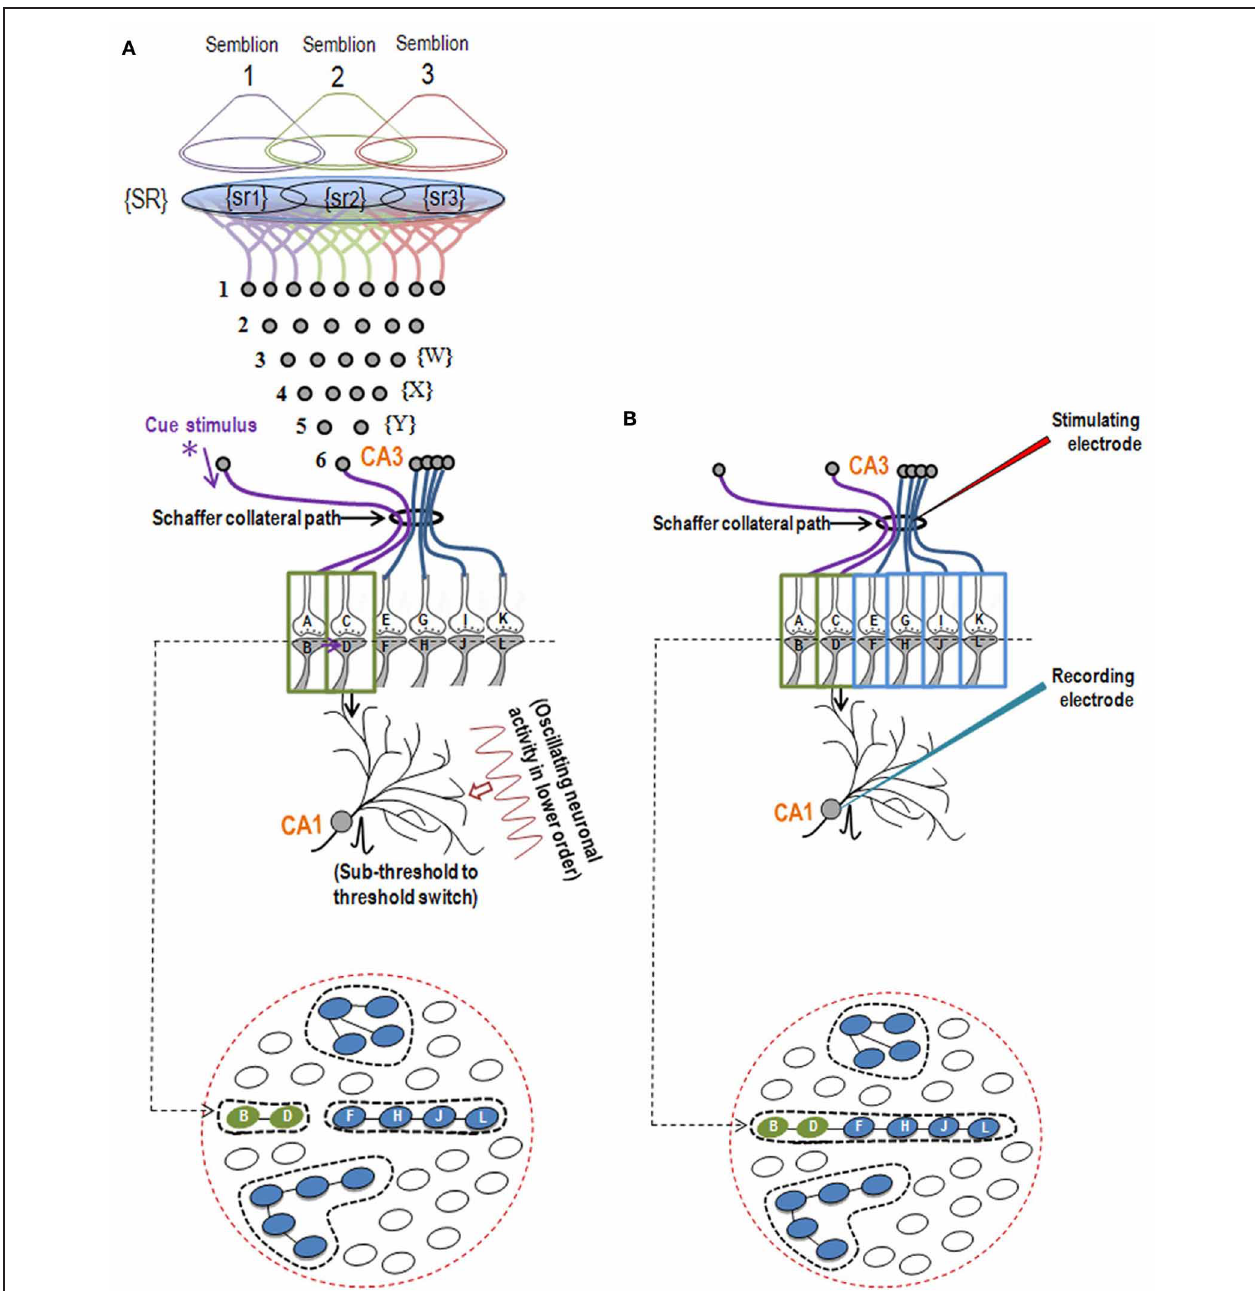
toward the sensory level identifies a set of sensory receptors {SR}. {sr1}, {sr2}, and {sr3} are subsets of {SR} and are capable of independently activating the CA3 neuron. Hypothetical packets of sensory stimuli activating sensory receptor sets {sr1}, {sr2}, and {sr3} are called semblions 1, 2, and 3, respectively. The activation of the postsynapse D by the cue stimulus can lead to the virtual internal sensation of semblions 1, 2, 3 or an integral of them. A CA1 neuron (place cell in the context of spatial memory) is shown to receive sub-threshold excitatory postsynaptic potential (EPSP) from oscillating neuronal activities of its lower order neurons. Cue stimulus-induced activation of postsynapse D reaches the soma of its neuron in the CA1 region. If the CA1 neuron receives a baseline summated EPSP short of one EPSP to